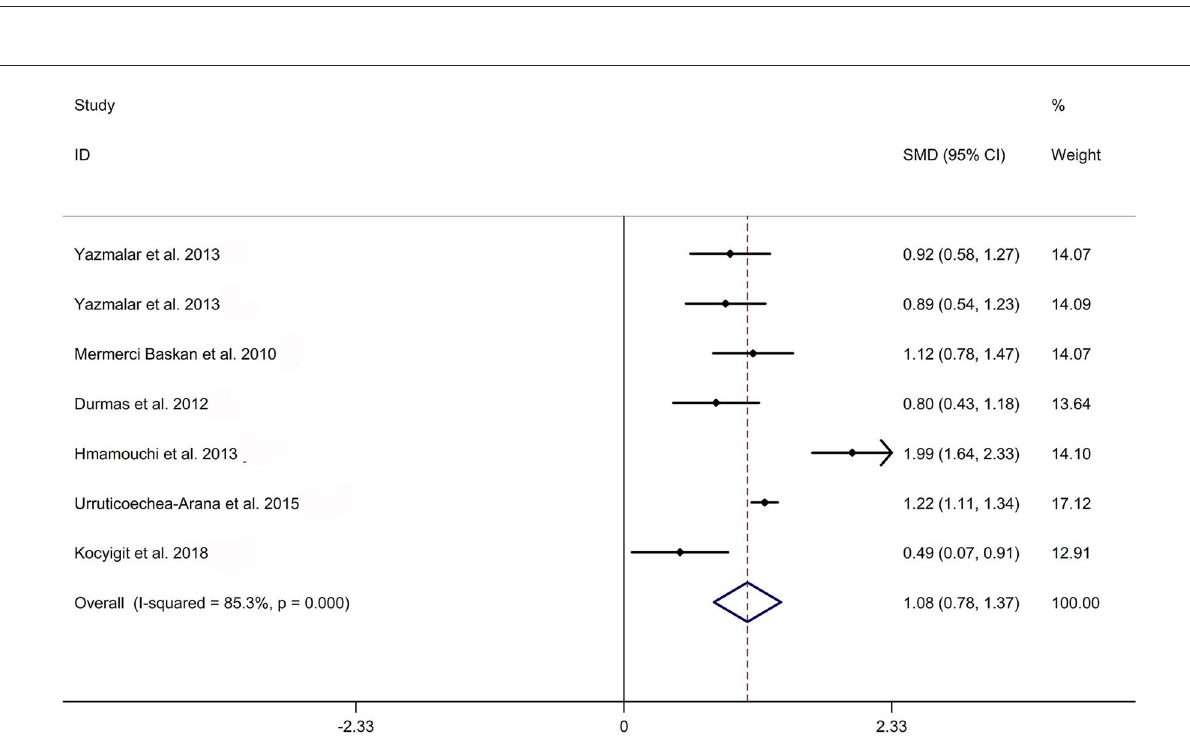
FIGURE4 Forest plot regarding comparison in peripheral CRP levels between AS and HC. AS, ankylosing spondylitis; CRP, C-reactive protein; HC, healthy